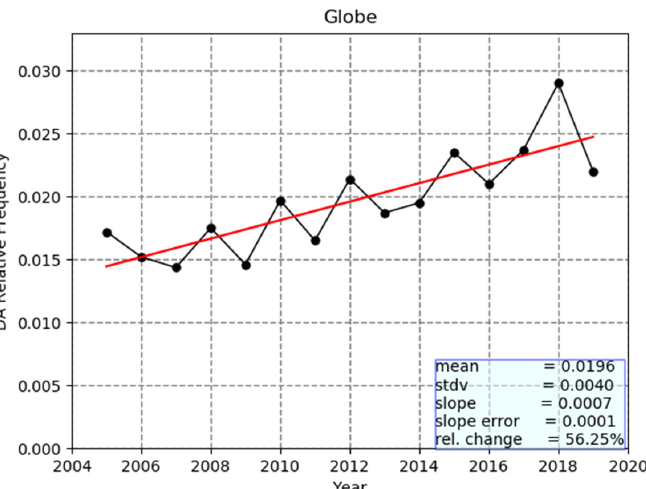
Figure 6. Inter-annual variability and linear trend of the relative frequency of dust aerosols (DA) over the globe, calculated by dividing the total absolute number of grid cells (1° × 1°) over which DA have been detected by the satellite algorithm by the total number of grids of the area for which the algorithm operated.